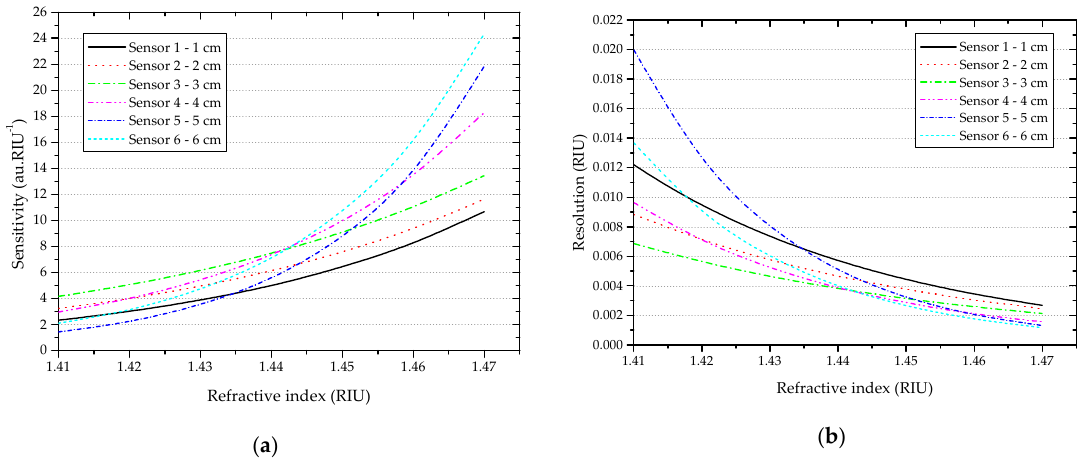
Figure 8. RI: 1.41–1.47: ( a ) Sensitivity and ( b ) resolution of the D-shaped sensors vs. length of the sensing region.